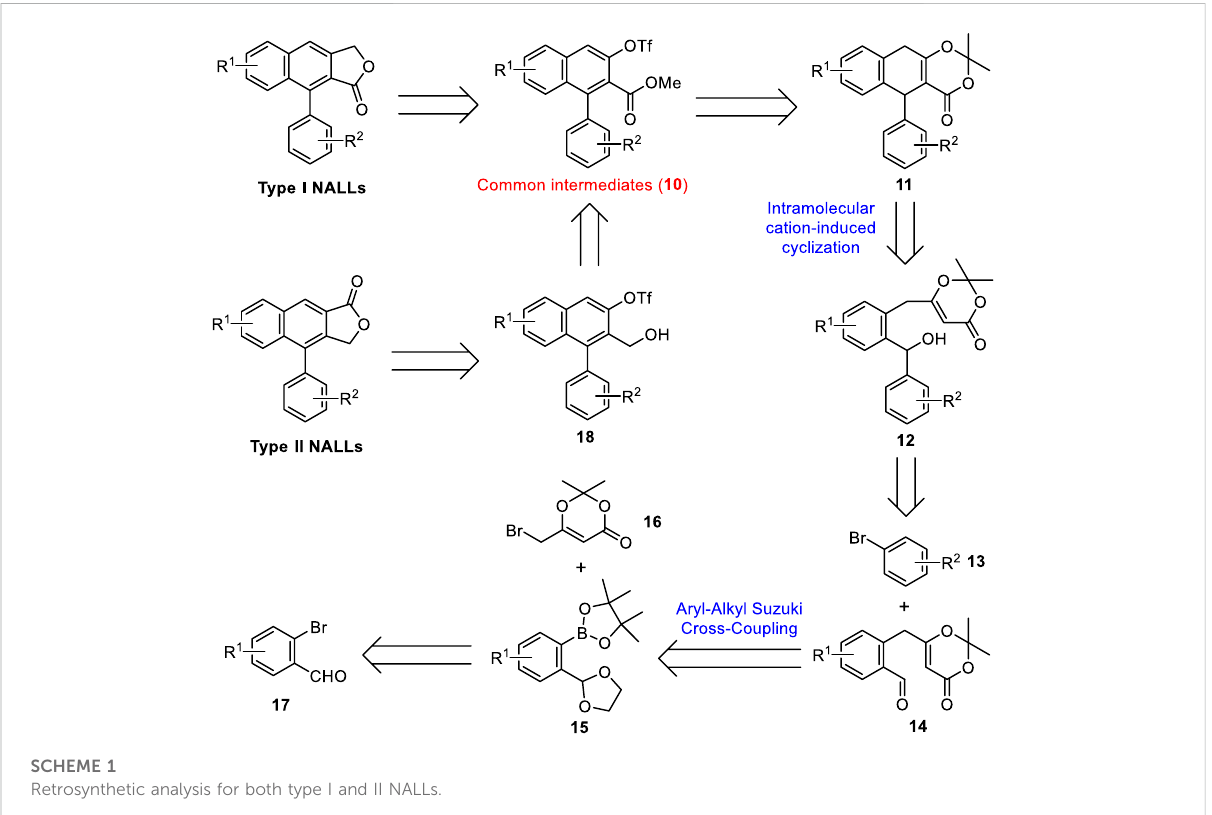
SCHEME 1 Retrosynthetic analysis for both type I and II